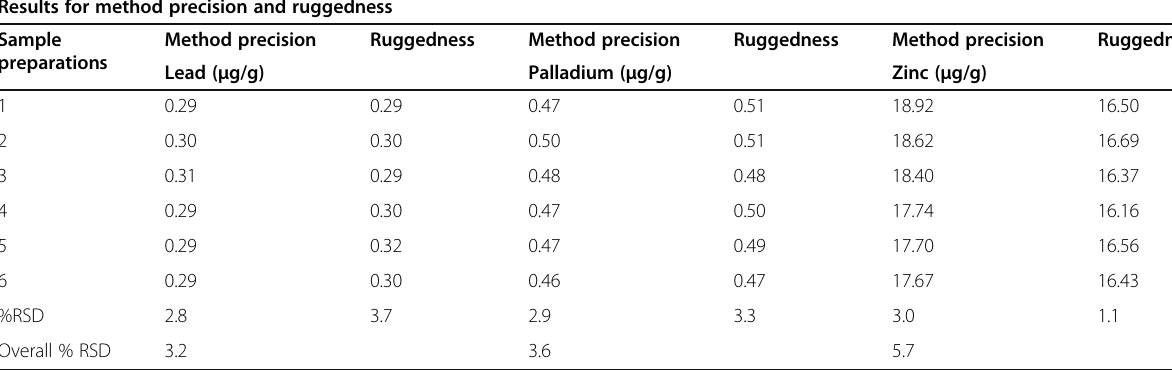
Table 10 Method precision and ruggedness